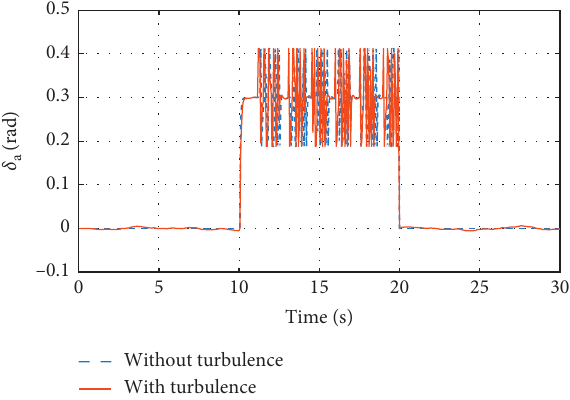
Figure 14: The variation of aileron deflection with the time.